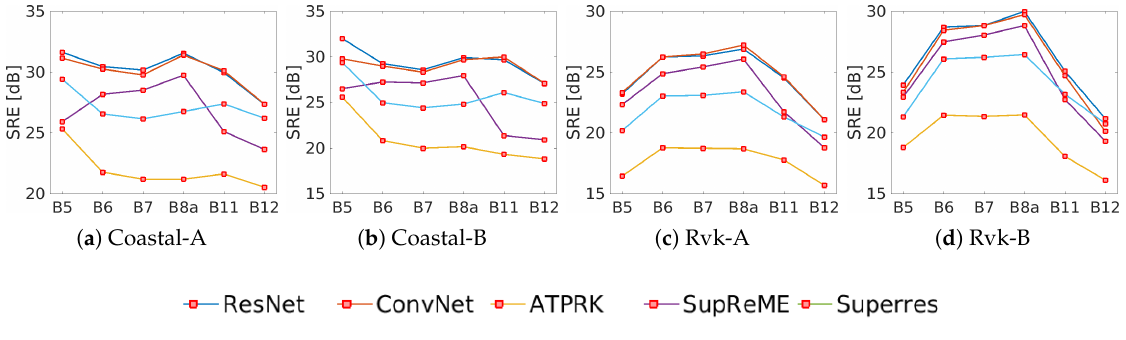
Figure 12. Plot of the band-wise SRE for all datasets and